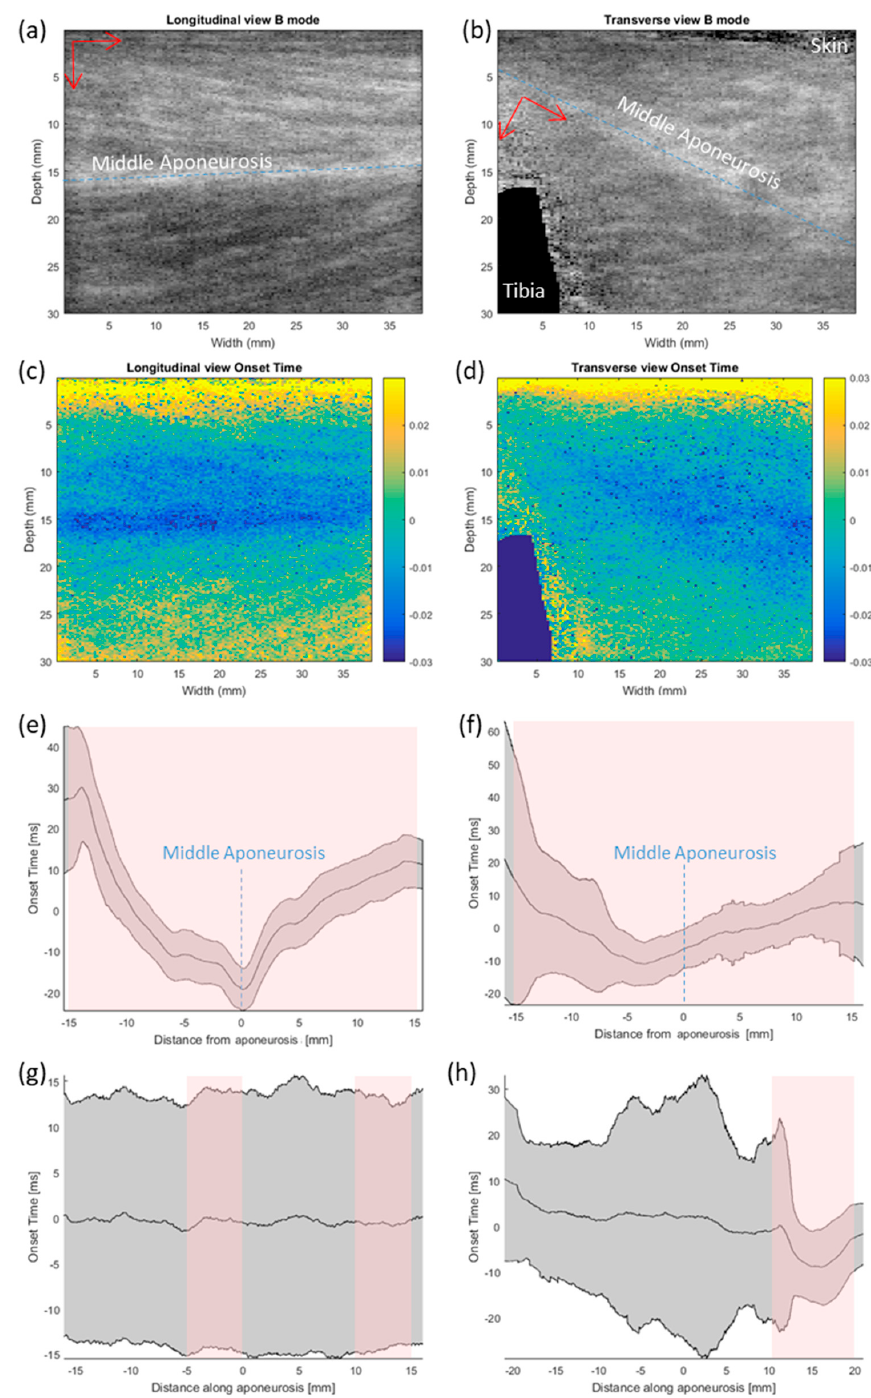
Figure 6. Muscle onset imaged in longitudinal view and transverse view. ( a , b ) show the averaged B-mode image in longitudinal view and transverse view. Blue dotted line indicates the midline of the middle aponeurosis. Red arrows mark the direction of distance taken to form charts ( e – h ). ( c , d ) show the corresponding onset time, with zero in time marking the mean of the area imaged. ( e , f ) show the variation in onset time against distance from the middle aponeurosis. The location of aponeurosis is marked in blue dotted line. ( g , h ) show the variation in onset time against distance along the middle aponeurosis. Grey area represents plus and minus one standard deviation at each position. Pink shaded areas denote significant trend at 5 mm intervals ( p < 0.05, independent t -test).